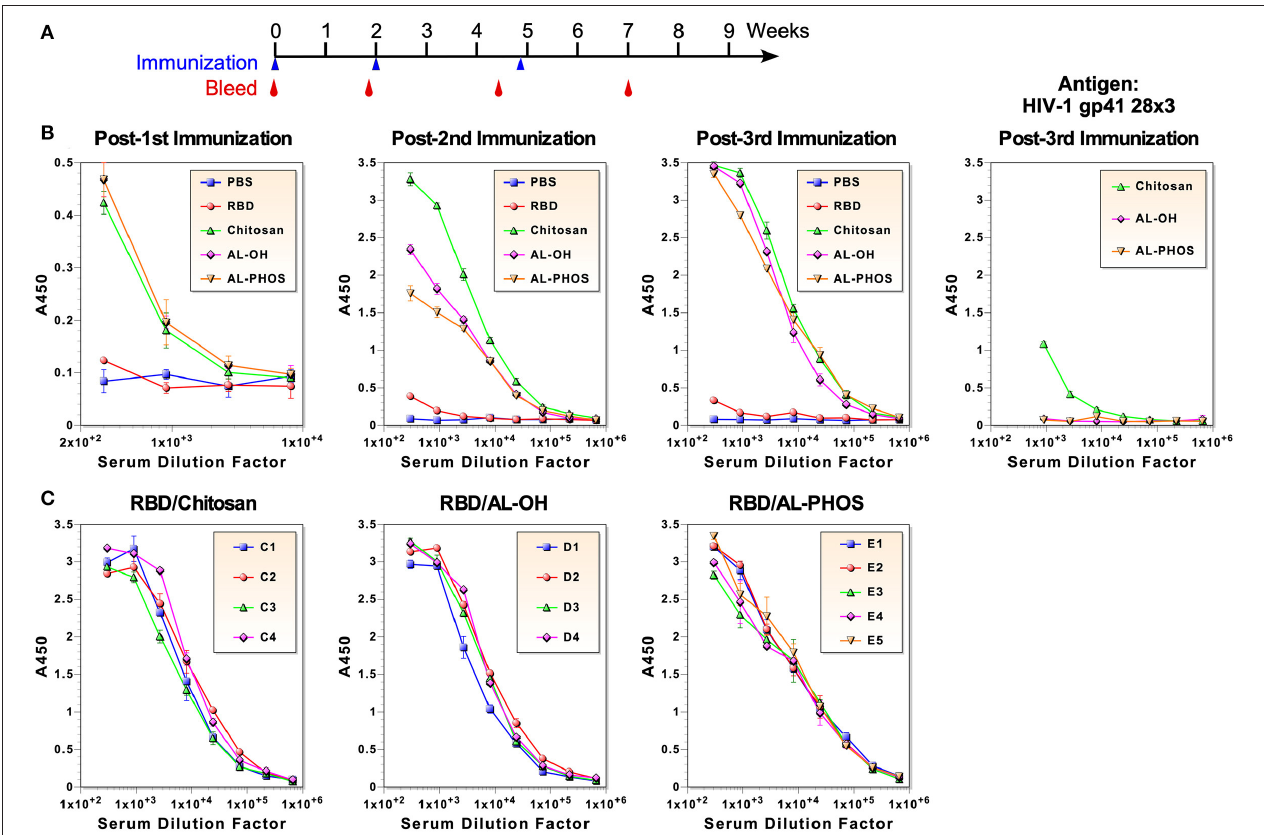
FIGURE 2 | Antibody responses against the RBD immunogen. (A) Immunization and blood collection schedule. (B) ELISA of pooled antisera collected about 2 weeks after each immunization. ELISA was also done using HIV-1 gp41-28 × 3 to assess antibodies elicited against the 6 × His tag (right panel). (C) ELISA of antisera from individual animals after the third